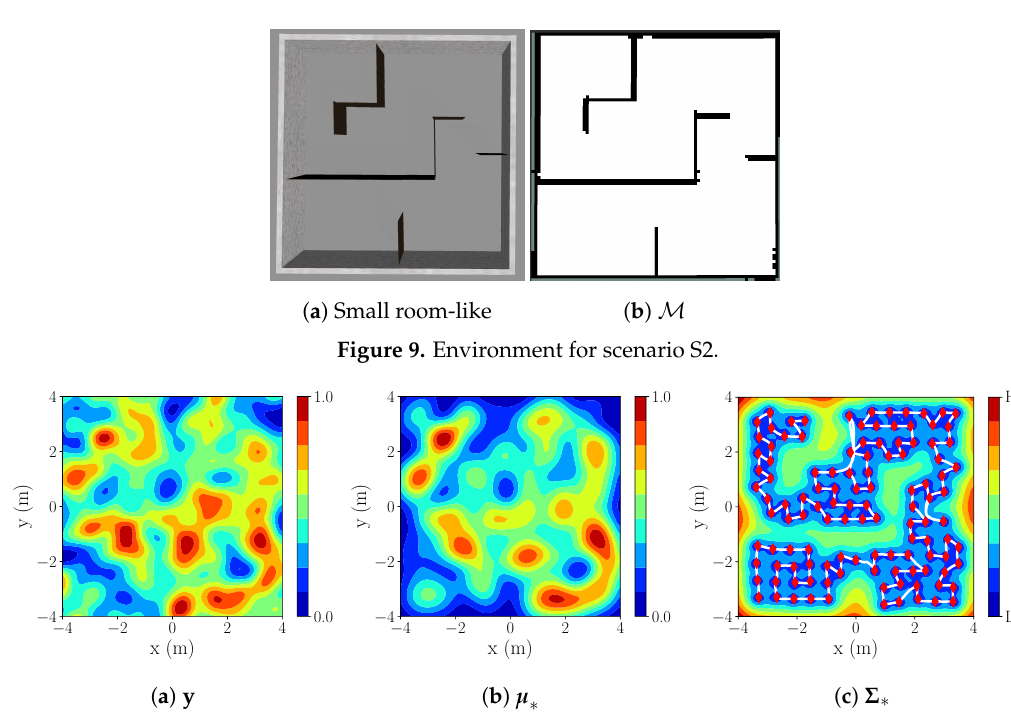
Figure 10. S2: IE r = 3 m , k = 3 l with red diamonds in (c) representing measurements and white lines trajectory.